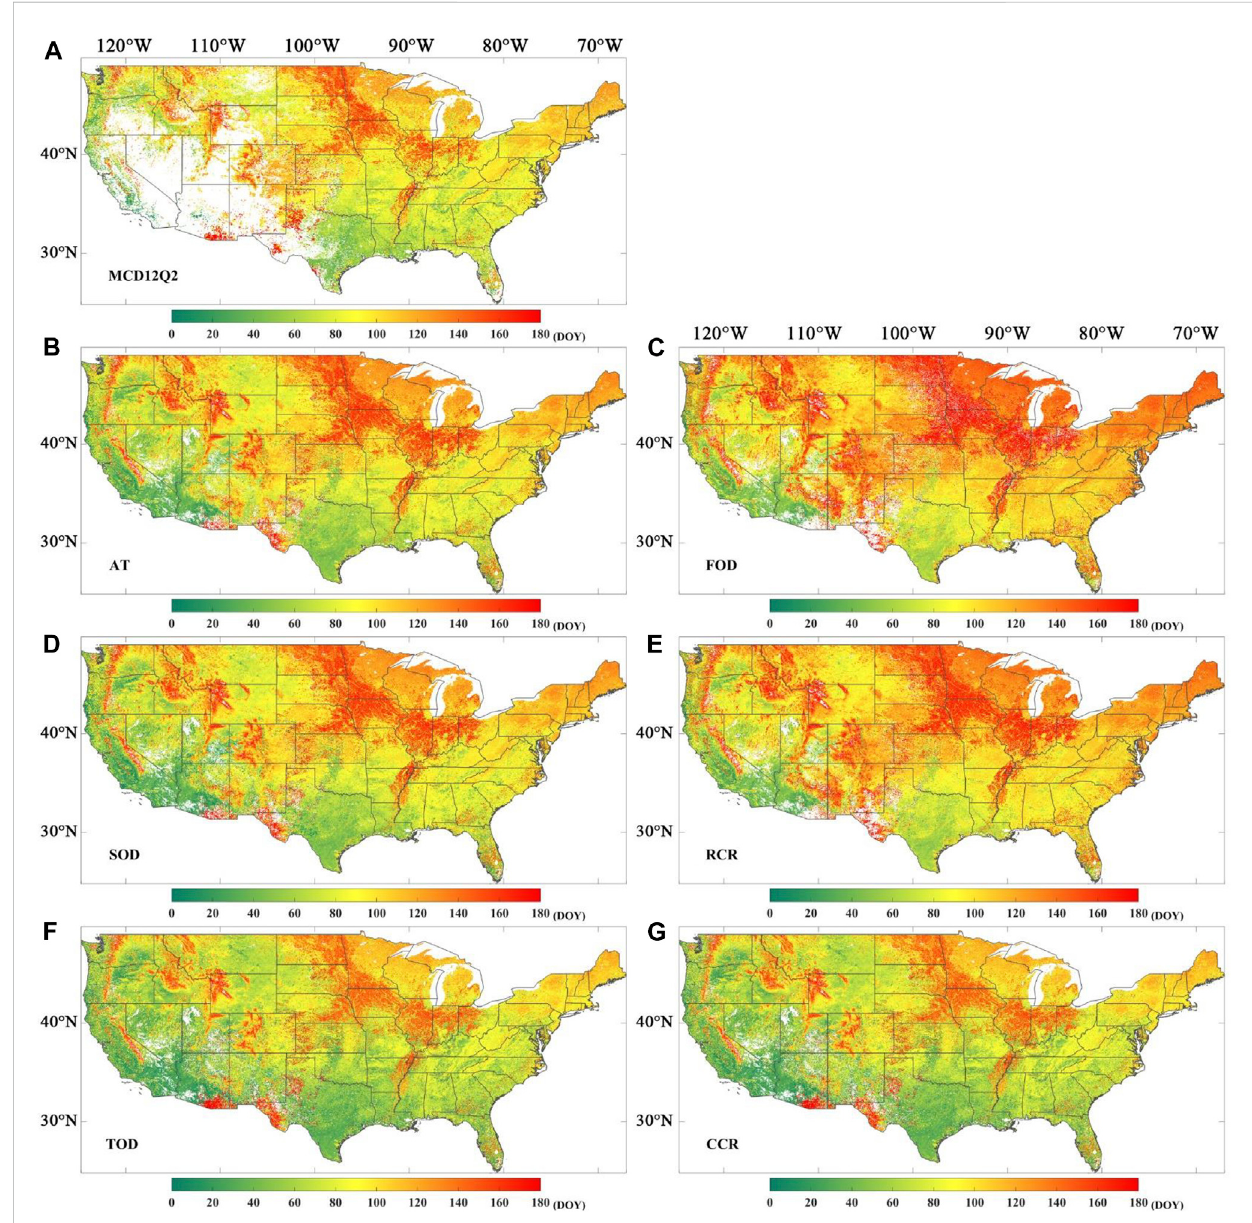
FIGURE 6 Spatial distribution for the start of season (SOS) in 2017. (A) SOS obtained from MCD12Q2; (B) SOS derived from MOD09Q1 EVI2 time series by amplitude threshold (AT); (C) SOS derived from MOD09Q1 EVI2 time series by fi rst-order derivative (FOD); (D) SOS derived from MOD09Q1 EVI2 time series by second-order derivative (SOD); (E) SOS derived from MOD09Q1 EVI2 time series by relative change rate (RCR); (F) SOS derived from MOD09Q1 EVI2 time series by third-order derivative (TOD); (G) SOS derived from MOD09Q1 EVI2 time series by curvature change rate